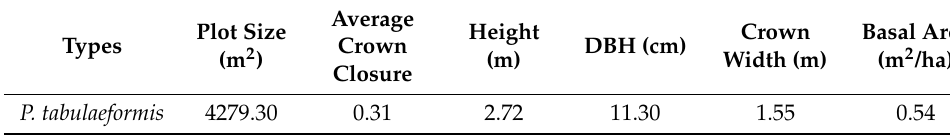
Table 1. Characteristics of the plantation in the sample plot.